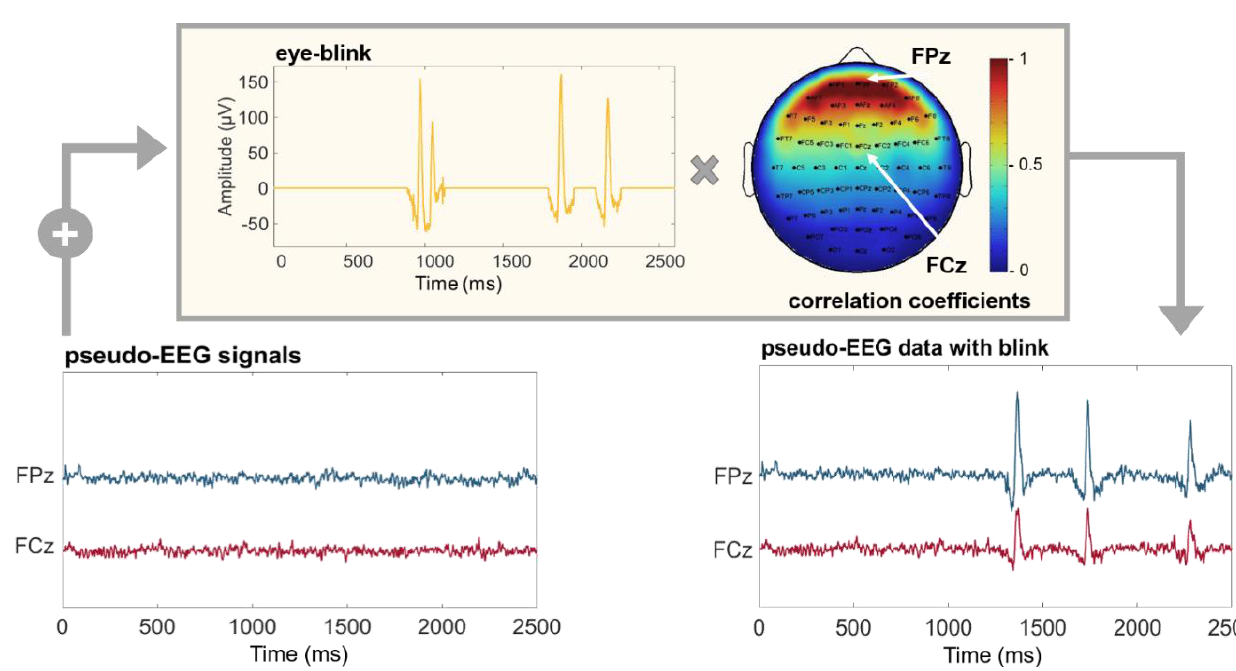
Figure 2. Pseudo-EEG data with ocular artifacts. Time series simulated using SEED-G toolbox (pseudo-EEG signals) and real ocular blinks (eye-blink) were summed up to obtain a realistic dataset (pseudo-EEG data with blink). The eye-blink component was weighted by a correlation coefficient whose value depends on the position of the simulated sensor (Pearson’s correlation between real EEG dataset acquired with a standard 60-channel montage, and an EOG channel). Frontal electrodes are maximally affected by the presence of the blinks; indeed, the correlation coefficient is equal to 1 for the electrode FPz (red portion of the mask). The same coefficient is equal to 0.5 for the sensor FCz, reflecting the fact that more central sensors show attenuated ocular